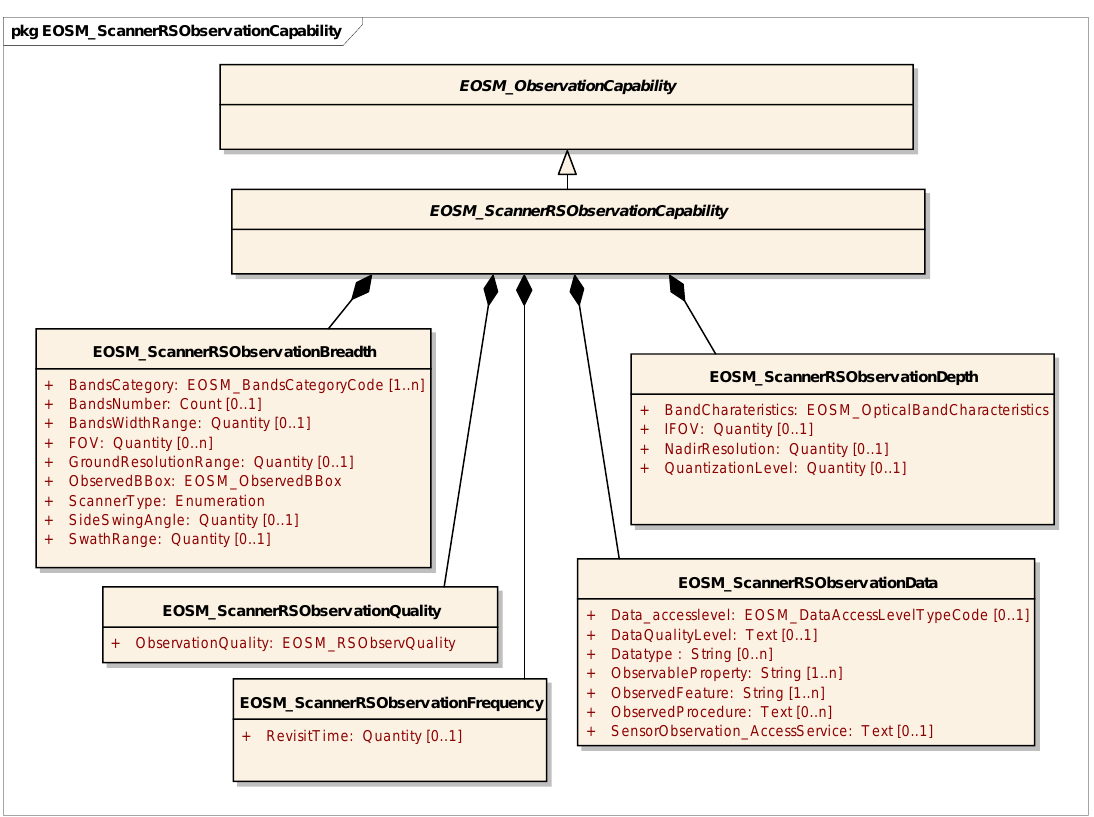
Figure 5. Remote-sensing scanner sensor observation capability metadata model.